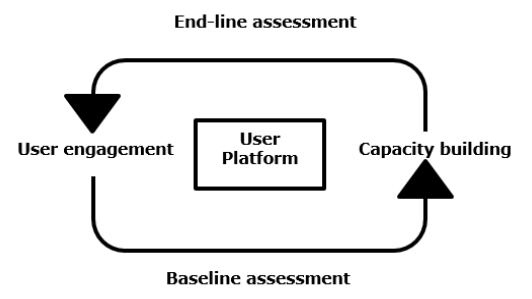
Figure 3. A five-step farmer engagement process for understanding the information needs of smallholder farmers in the Lower Bengal Delta.